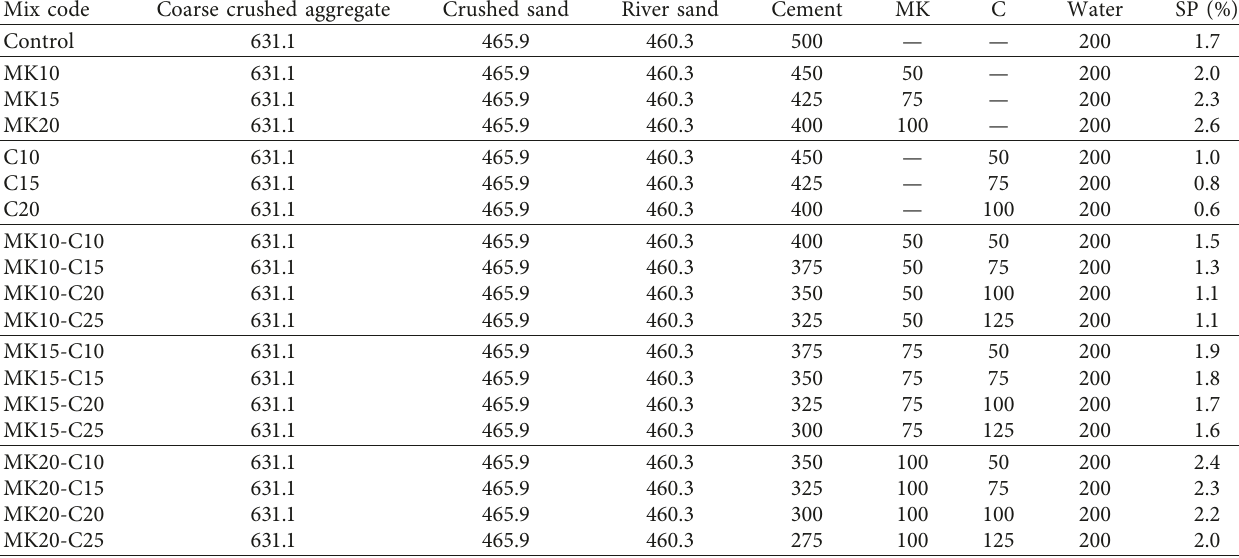
Table 3: Concrete mixture proportion for a cubic meter (kg/m 3